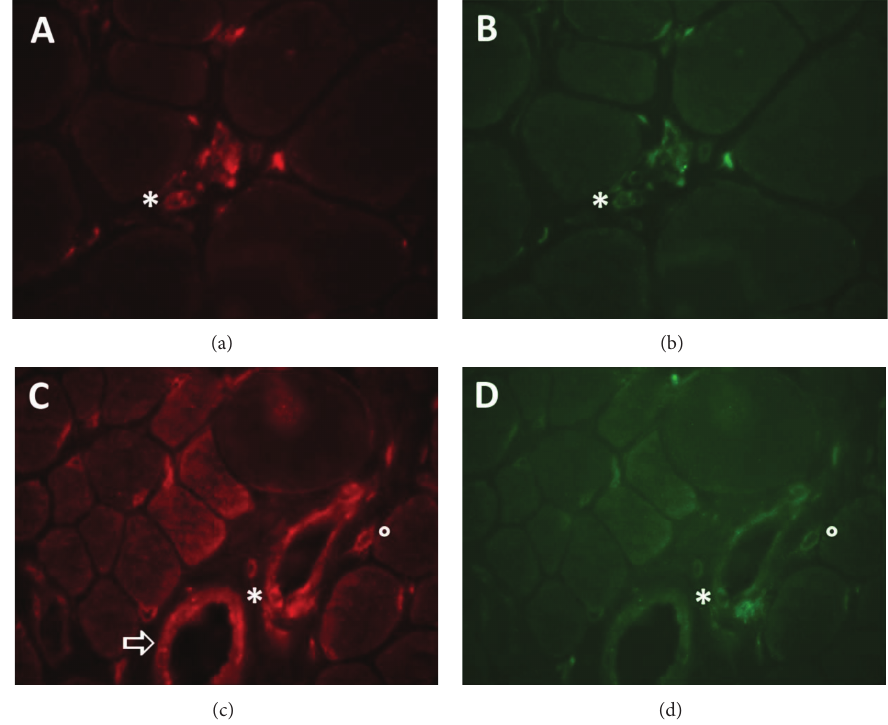
Figure 1: Immunofluorescent detection of TNF- 𝛼 and IFN- 𝛾 in Duchenne muscular dystrophy. (a)-(b) Muscle biopsy taken from an 8-year- old patient with Duchenne muscular dystrophy caused by duplication of dystrophin exon 2, resulting in severe muscle damage, few groups of revertant fibers, and strong utrophin staining. TNF- 𝛼 (red in (a)) is detected in a small cluster of inflammatory cells and colocalizes with CD3 (green in (b)). The asterisk is an indicative that helps to identify an individual TNF- 𝛼 + T cell. (c)-(d) Muscle biopsy taken from a 2-year-old patient with Duchenne muscular dystrophy caused by c.5299-5302dupATTT in dystrophin exon 37. Myopathological evaluation of the biopsy described definite muscle damage, few groups of revertant fibers, and strong utrophin staining. IFN- 𝛾 (red in (c)) is strongly expressed on the blood vessel endothelium (arrow) and on perivascular CD3+ T cells (green in (d)). Highlighted are an IFN- 𝛾 + CD3+ T cell attached to the luminal side of the blood vessel (asterisk) and an interstitial IFN- 𝛾 + CD3+ T cell